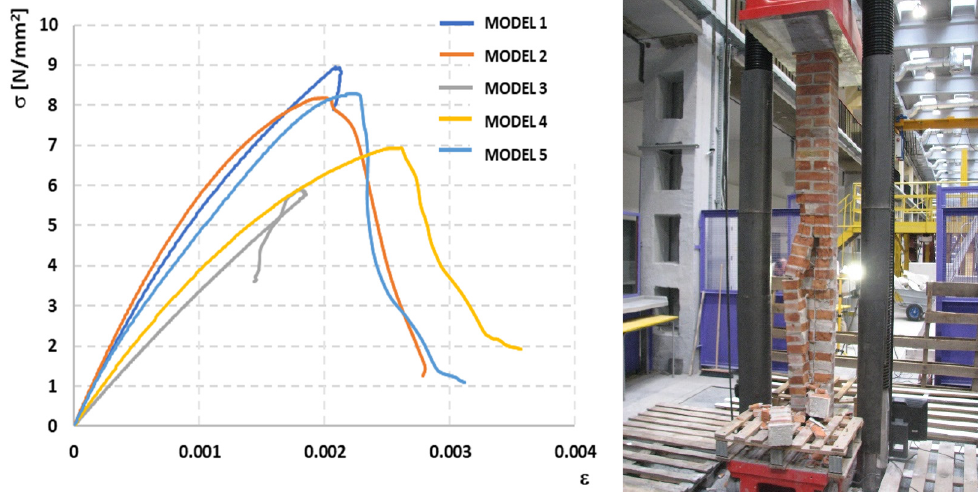
Figure 18. Stress-strain under compression relationship of clay brick pillars under uniform load and view of an example element after the test [23].